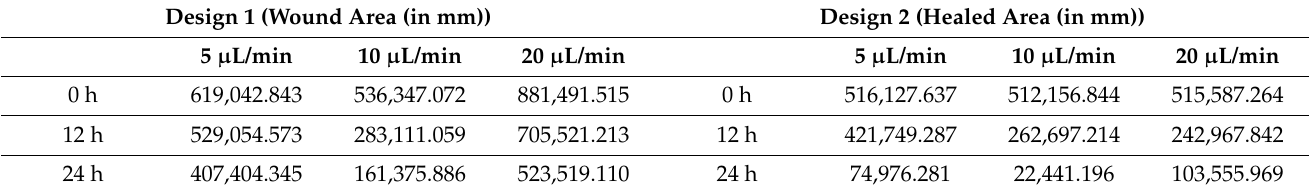
Figure 12. Brightfield phase images of the fibroblast cells under design 2 at 0 h, 12 h and 24 h in the silk film placed inside slot in the microfluidic device. Micrographs of the wound-healing process of chip 2 under a flow rate of 5 µ L/min ( a , d , g ), 10 µ L/min ( b , e , h ) and 20 µ L/min ( c , f , i ) taken using ZEISS Axio Vert.A1 inverted microscope. Image analysis was performed using ImageJ software. Scale bar 200 µ m. Table 4. Table showing effect of cell migration at different flow rate inside design 1 and design 2. Zero hour is considered when a cell reaches confluency in case of design 1, whereas in case 2, it is the time when wound is created inside the